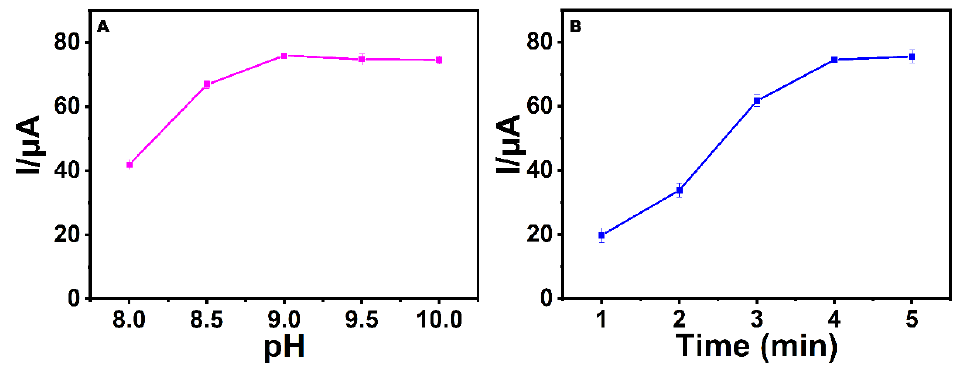
Figure 5. Results of optimization studies: pH of PBS ( A ) and incubation time of ALP ( B ).